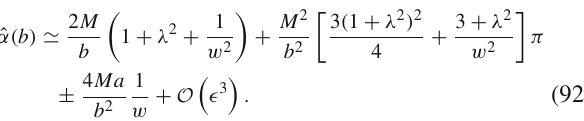
of the small parameters (cid:23) M and (cid:23) a . Therefore, the devia-